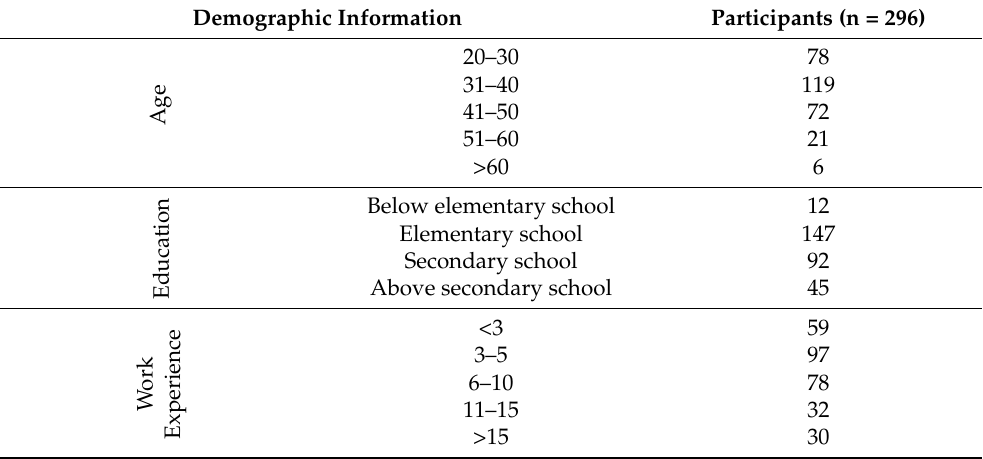
Table 3. Demographic information of the workers.